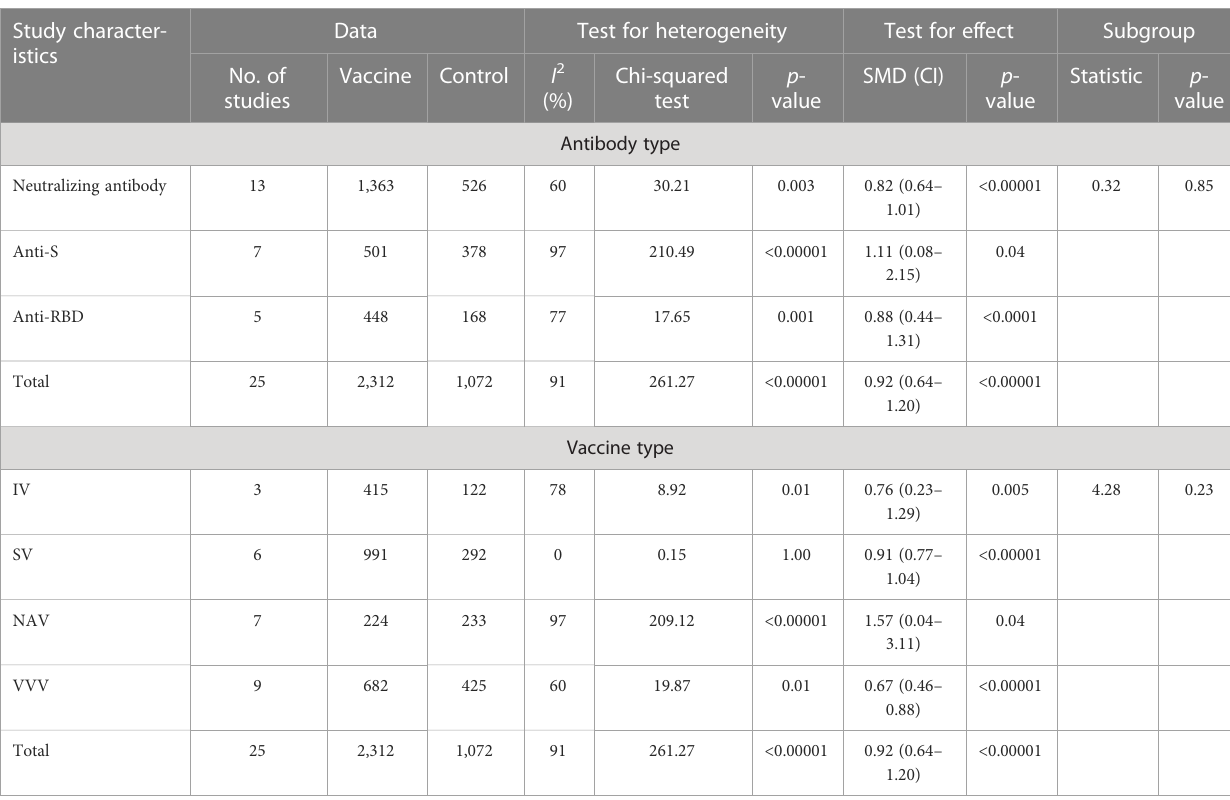
TABLE 3 Subgroup analysis for geometric mean titers (GMT). Study character-